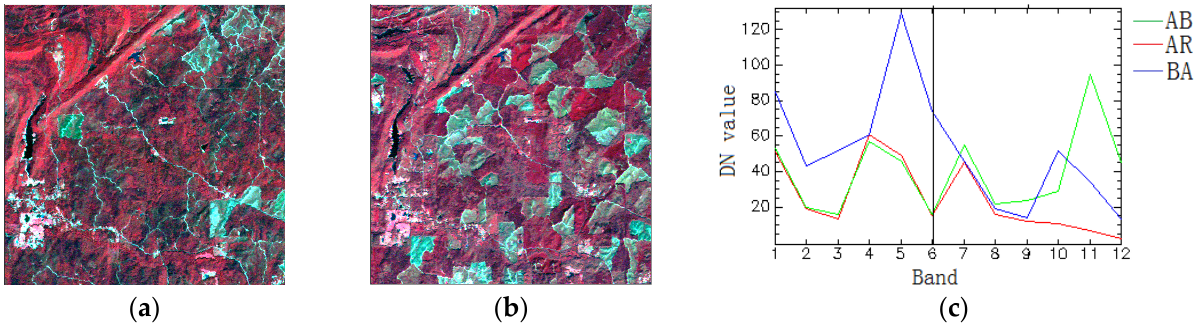
Figure 10. Real Multitemporal image data 2 (wavelength: R: 860 nm, G: 655 nm and B: 560 nm). ( a ) the original TM image in 2001, ( b ) the original TM image in 2009 and ( c ) three changed endmember spectral signature descriptions.